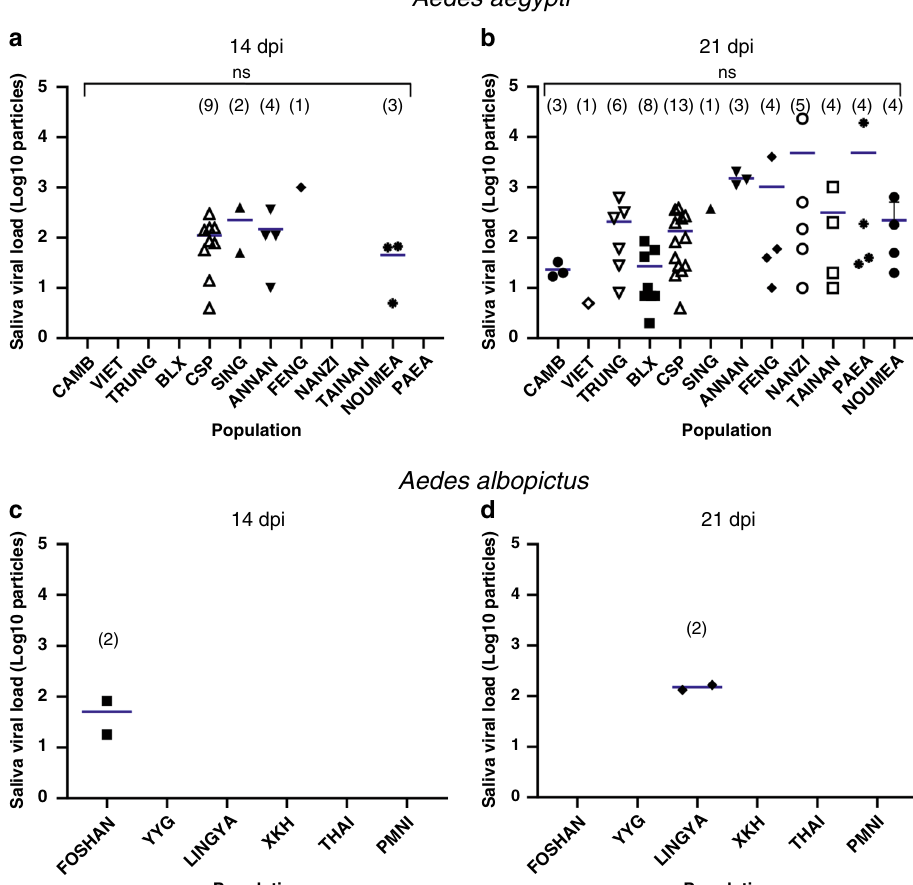
Fig. 3 Viral loads measured in individual mosquito saliva at 14 and 21 days after an infectious blood meal with West-African YFV. a , b Saliva viral loads of Aedes aegpti at 14 and 21 dpi; c , d saliva viral loads of Aedes albopictus at 14 and 21 dpi. Saliva was collected for 30 min using the forced salivation technique by removing legs and wings and inserting a tip containing FBS in mosquito proboscis. Salivas were titrated on C3/36 cells and the numbers of viral particles are expressed in ffu/saliva. ns (non-signi fi cant) indicates the lack of statistical signi fi cance for comparisons using the Kruskal – Wallis test (two-sided test; P > 0.05). Bars indicate the mean. In brackets are the numbers of mosquitoes tested. dpi days post-infection. Source data are provided in Supplementary Data 1 fi